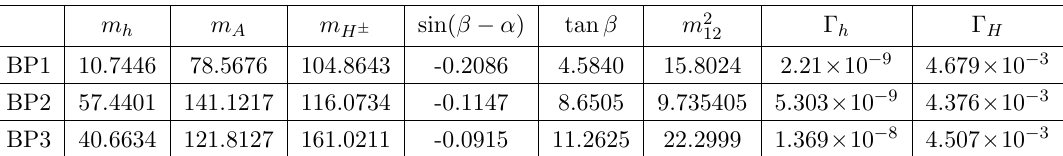
Table 2. Input parameters and widths corresponding to the selected BPs. All masses and widths are in GeV and for all points m H = 125 GeV.